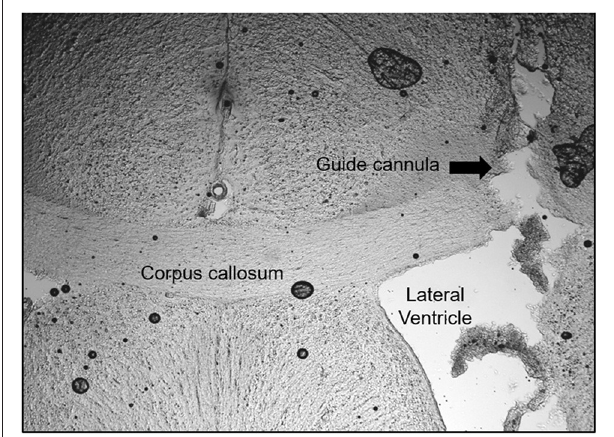
FIGURE 6 | Sites of the unilateral microinjections into the lateral ventricle. Photomicrograph of a coronal section (60 µ m) of the brain of one rat, representative of the group, showing microinjections tracing in the lateral ventricle. Arrows show the tract of the